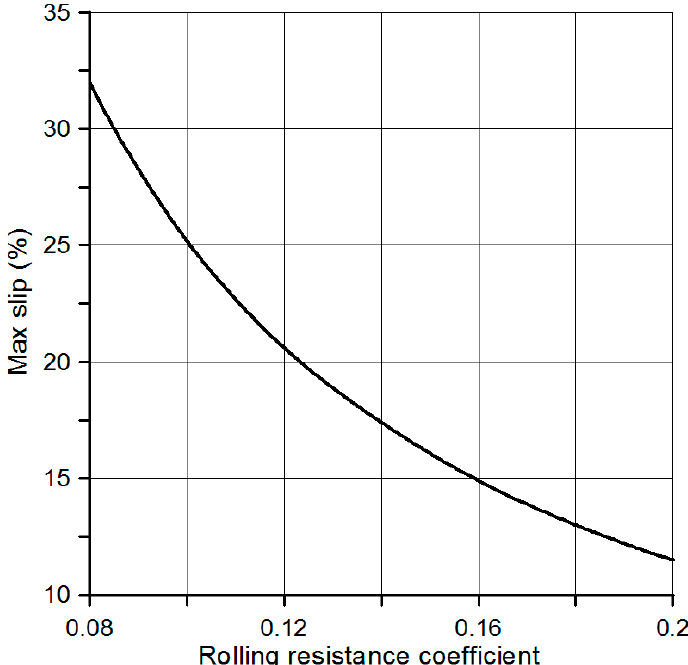
Figure 4. Dependence on the maximum tractor’s wheels slip δ max from the rolling resistance coeffi- cient f k .